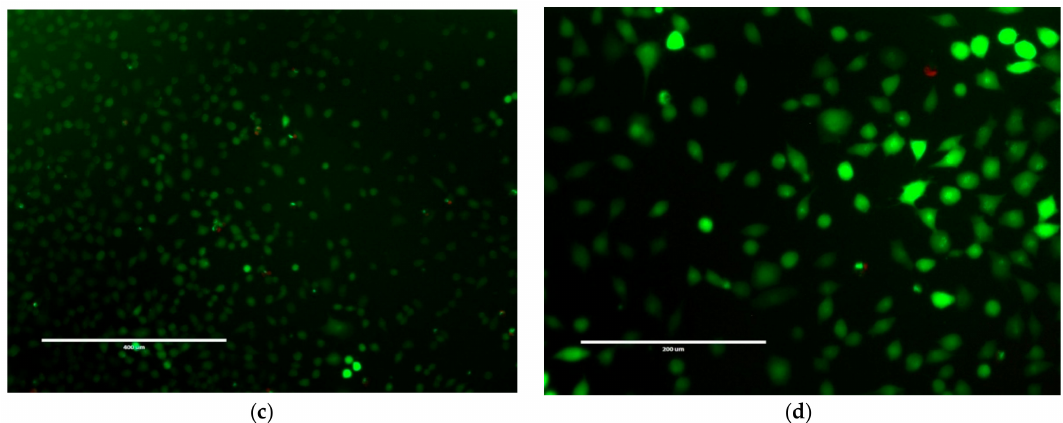
Figure 9. LIVE/DEAD ® fluorescence of NCTC 929 cells with ( a ) 20 µ M; ( b ) 100 µ M; ( c ) 200 µ M; ( d ) 500 µ M of NapFFKK-OH. Green staining indicates live cells, red staining indicates dead cells. Each image was taken after 24 h incubation with NapFFKK-OH, scale bar: ( a – c ) = 400 µ m ( d ) = 200 µ